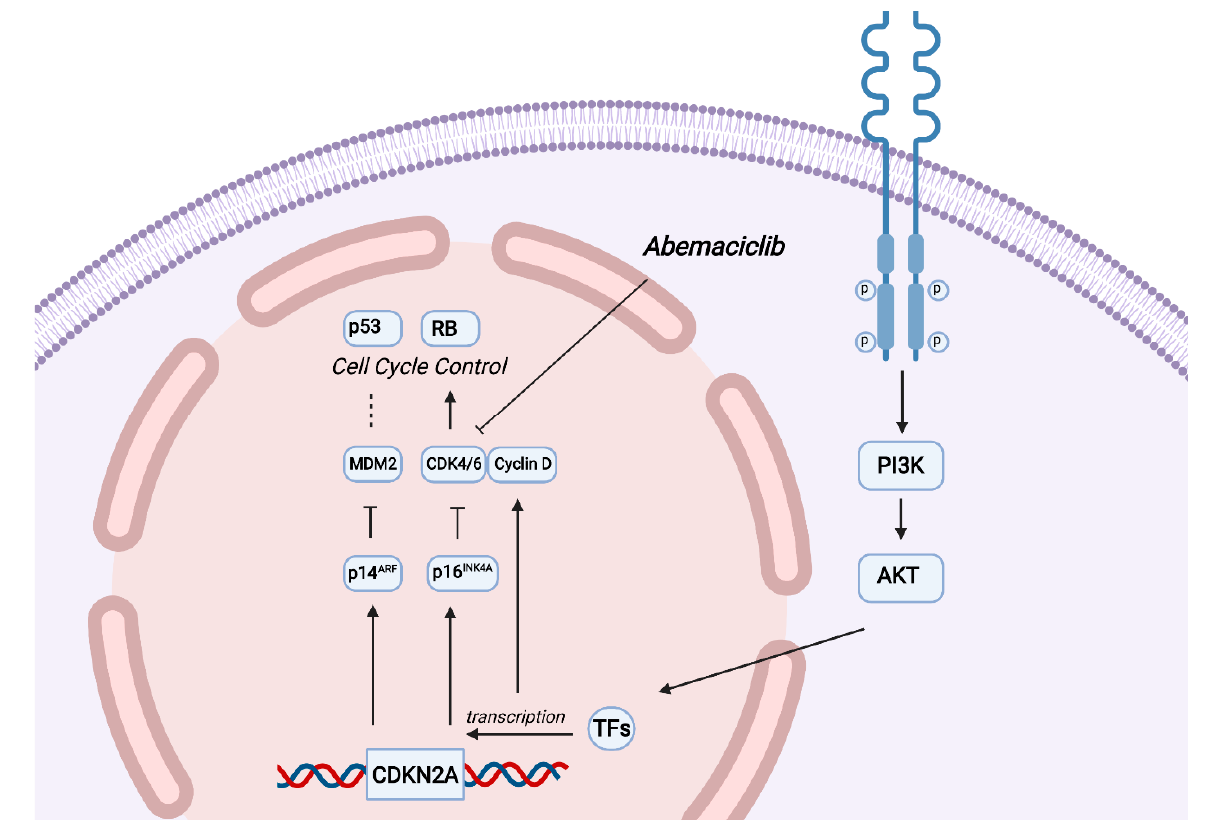
Figure 5. Abemaciclib effect on CDKN2A and PI3K mutated cancer cells. CDKN2A encodes the tumor suppressors p16ink4a, and p14ARF. PI3K-AKT pathway controls several transcription factors (TFs), leading to an increase in Cyclin D expression. Abemaciclib prevents cell cycle progression, inhibiting the complex CDK4/cyclin D, responsible for the phosphorylation and inhibition of the RB tumor-suppressor gene.